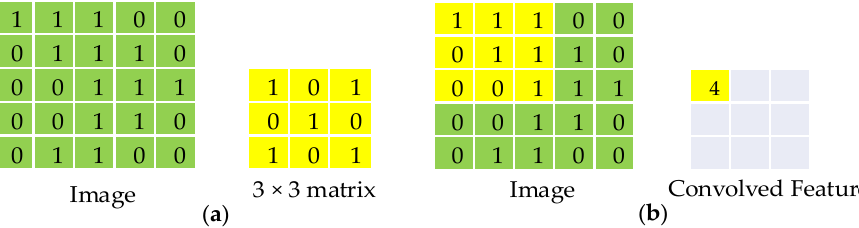
Figure 3. ( a ) Schematic diagram of the convolution kernel; ( b ) the convolution kernel convolves the original image.